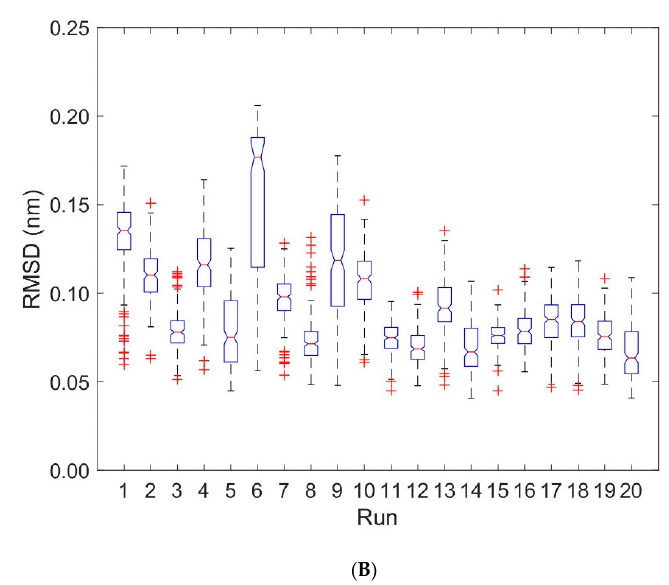
Figure 7. Boxplots of RMSD for MHC α 1 and MHC α 2. RMSD values are computed every 0.2 ns with